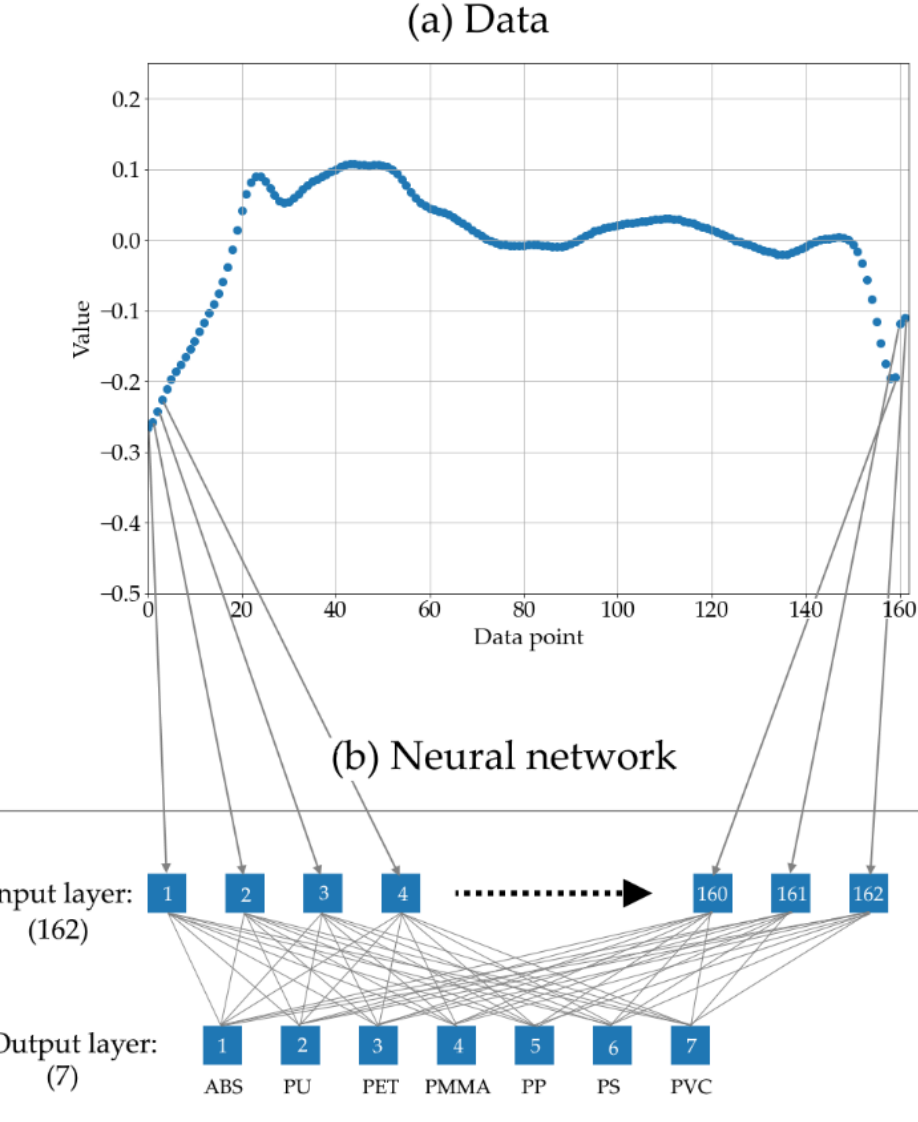
Figure 5. ( a ) One hundred and sixty-two float numbers representing a standardized LAMR are fed into the 162 nodes of the input layer of the neural network ( b ). The neural network is a single-layer feedforward network, where seven output nodes (each representing one type of plastic) are densely connected to all input nodes.